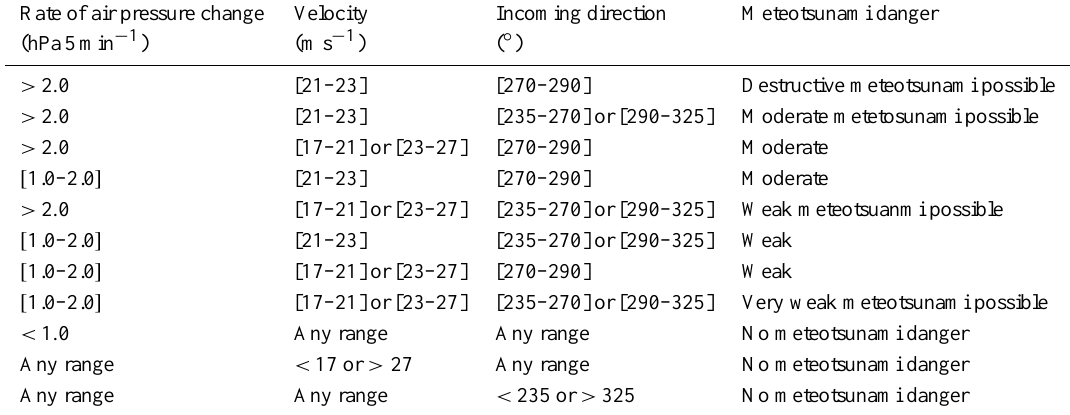
Table 1. Preliminary meteotsunami warning matrix for Stari Grad and Mali Ston.